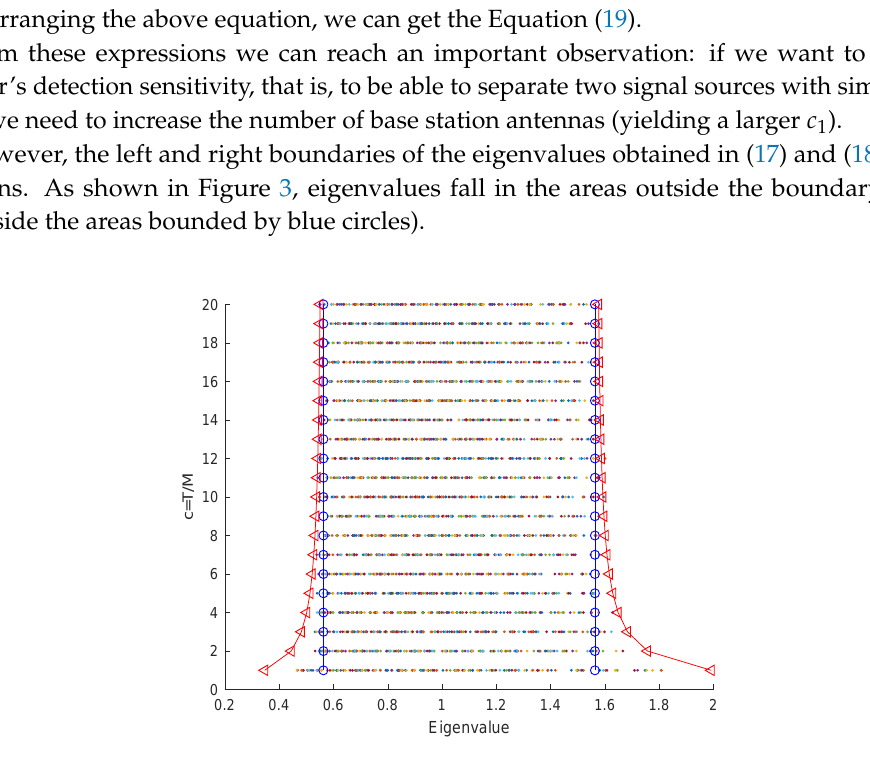
Figure 3. Empirical eigenvalue distribution without the effect of noise, when p b = 1 and M The blue circles represent the boundaries of the eigenvalues obtained from (17) and (18). The red triangle represent the boundaries from (25) and (26) that incorporate the correction item ε